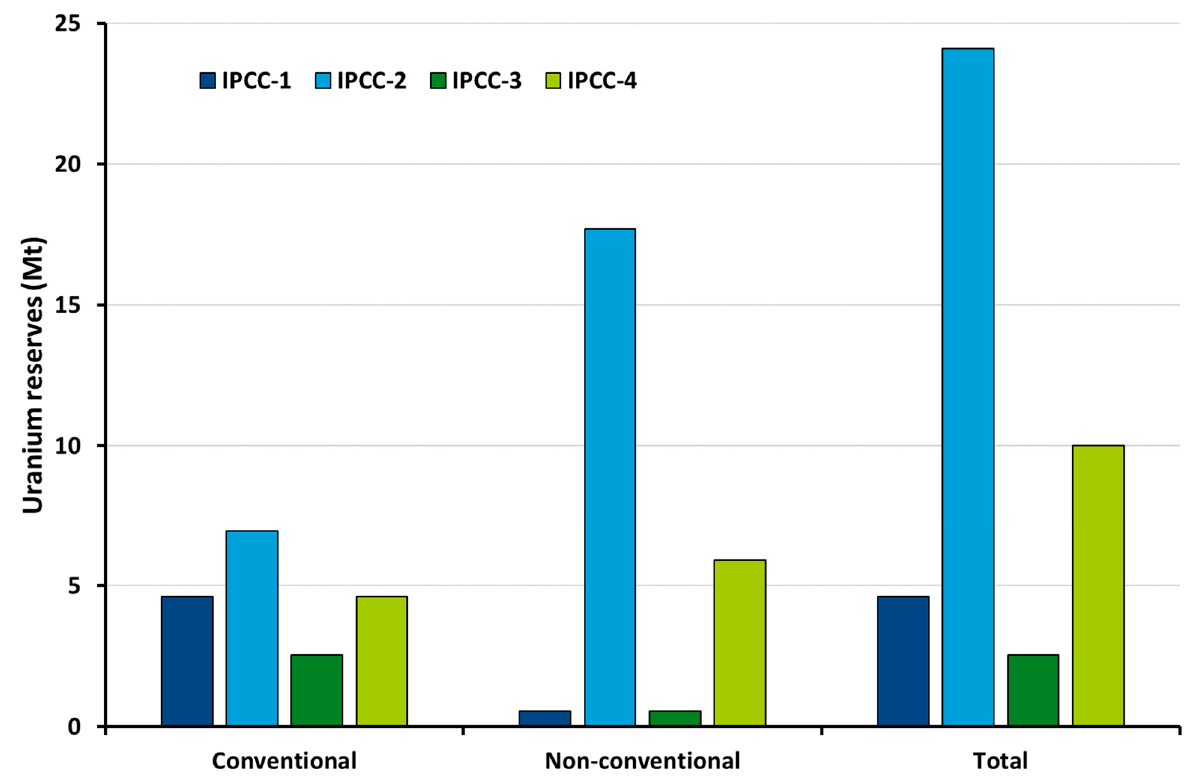
Figure 5. Uranium reserves estimated by type and macro ‐ region. Redrawn from data in [34].